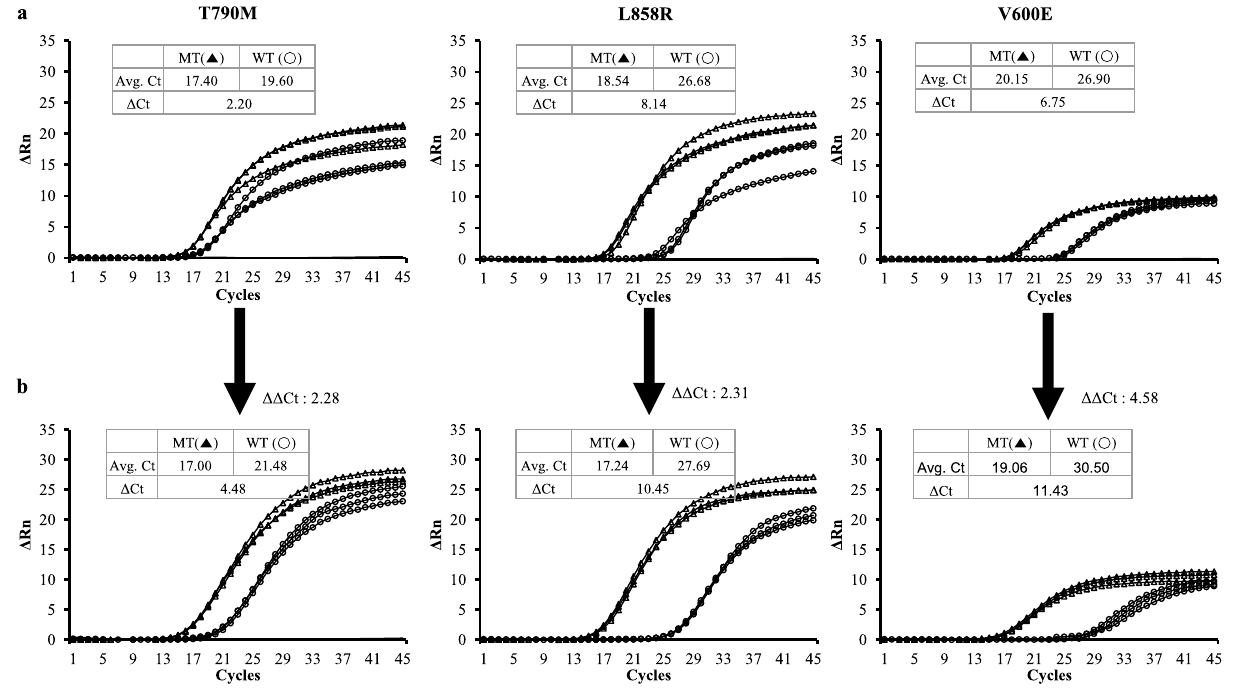
Figure 2. Efficiency test of standard AS-PCR and STexS utilized PCR. qPCR plots of general ( a ) and STexS PCR ( b ). Each Primer was designed to target three types of variation of the gene EGFR; T790M, L858R and BRAF V600E. Each general PCR/STexS PCR was performed to evaluate whether the primer can effectively differentiate matched against mismatched templates. qPCRs were performed with 790-F58-1 for EGFR T790M, 790-F58-1 for EGFR T790M 858-F25 for EGFR L858R and 1799-F11 for BRAF V600E, and 1 uM of AHP3 as dbOligo for STexS PCR was